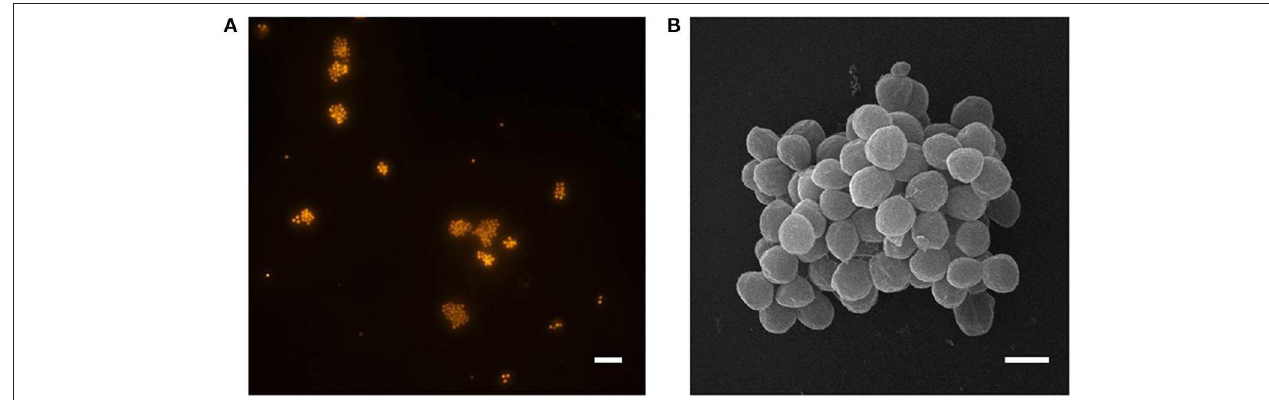
FIGURE 3 | Micrographs of Ca. N. arcticus Kfb in enrichment cultures at 20 ◦ C. (A) DOPE-FISH micrograph using the archaea-specific probe ARCH 915, showing typical Ca. N. arcticus Kfb cell aggregates and occasional single cells. The scale bar represents 10 µ m. (B) Scanning electron micrograph of a cell aggregate. Cells have an average diameter of 0.8 µ m (ranging from 0.6 to 1.0 µ m). The scale bar represents 1 µ m.